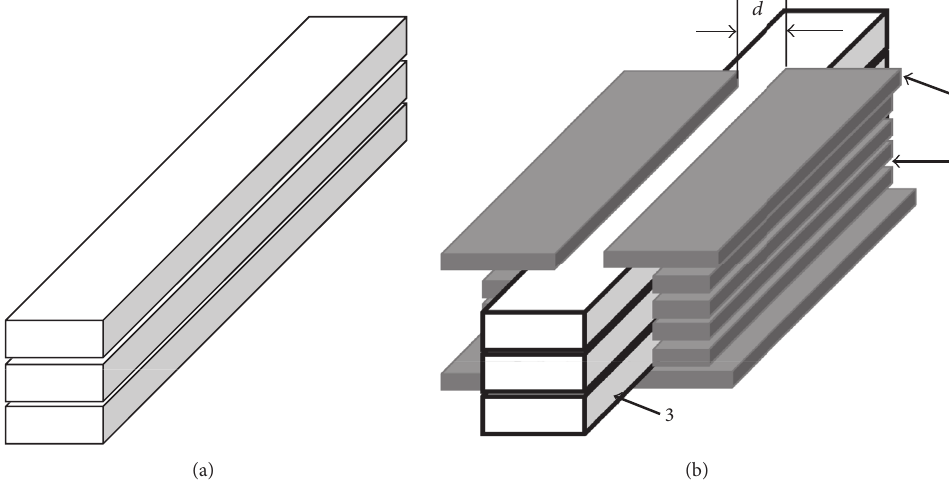
Figure 2: A schematic layout of three-layer stacked conductor without (a) and with (b) ferromagnetic shunt materials. 1: four pieces of 5 mm width ferromagnetic sheets; 2: eight pieces of 3 mm width ferromagnetic sheets; 3: three HTS tapes; and 𝑑 : a space gap between 5 mm width ferromagnetic sheets above tape wide